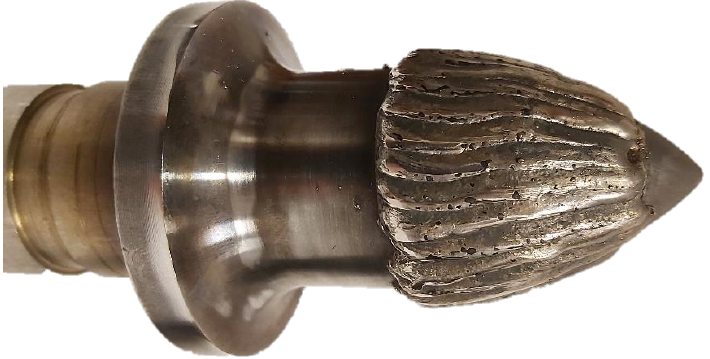
Figure 2. Hard coating applied with robotized GMAW process on the working surface of conical